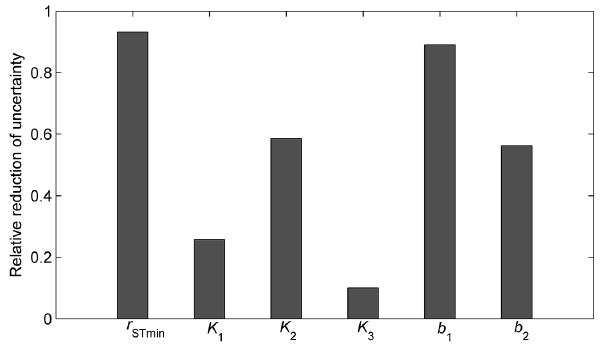
Figure 5. Relative uncertainty reductions in the length of 95% cred- ible interval form prior to posterior distribution.